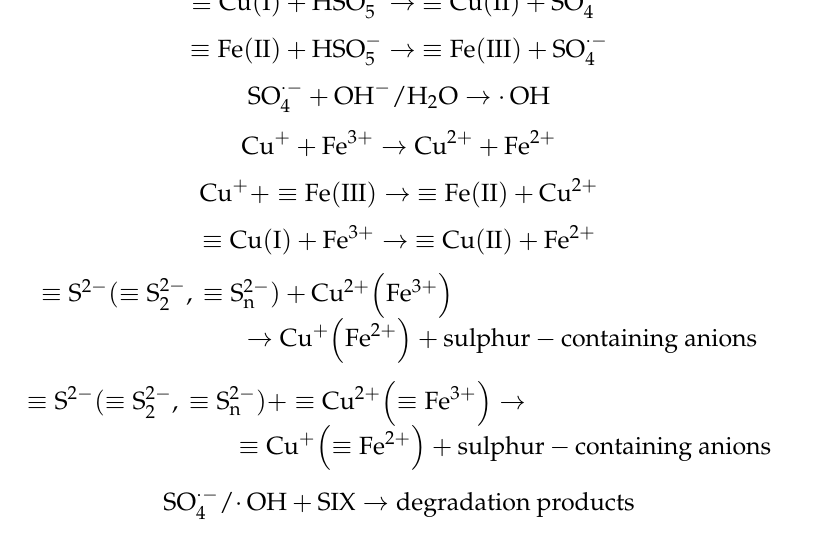
9 of 15 (8)). During the reaction, the activators themselves were oxidized. Second, SO (cid:2872)∙(cid:2879) trans ‐ formed to ∙ OH via reaction with H 2 O and OH − (Equation (9)). Third, Cu + and surface S species ( ≡ S 2 − , ≡ S (cid:2870)(cid:2870)(cid:2879) , and ≡ S (cid:2924)(cid:2870)(cid:2879) ) are reductants and transformed the oxidized forms of ac ‐ tivators back to their reduction states (Equations (10)–(14)). Finally, the generated SO (cid:2872)∙(cid:2879) and  OH interacted with SIX and degraded this contaminant (Equation (15)). It is worth mentioning that the direct oxidation of SIX by PMS also contributed to the degradation, although this mechanism was relatively much less important.